Question: Name the type of graph shown.
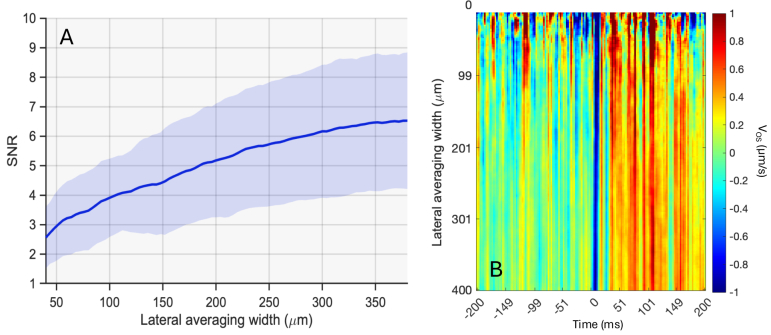
Answer: line